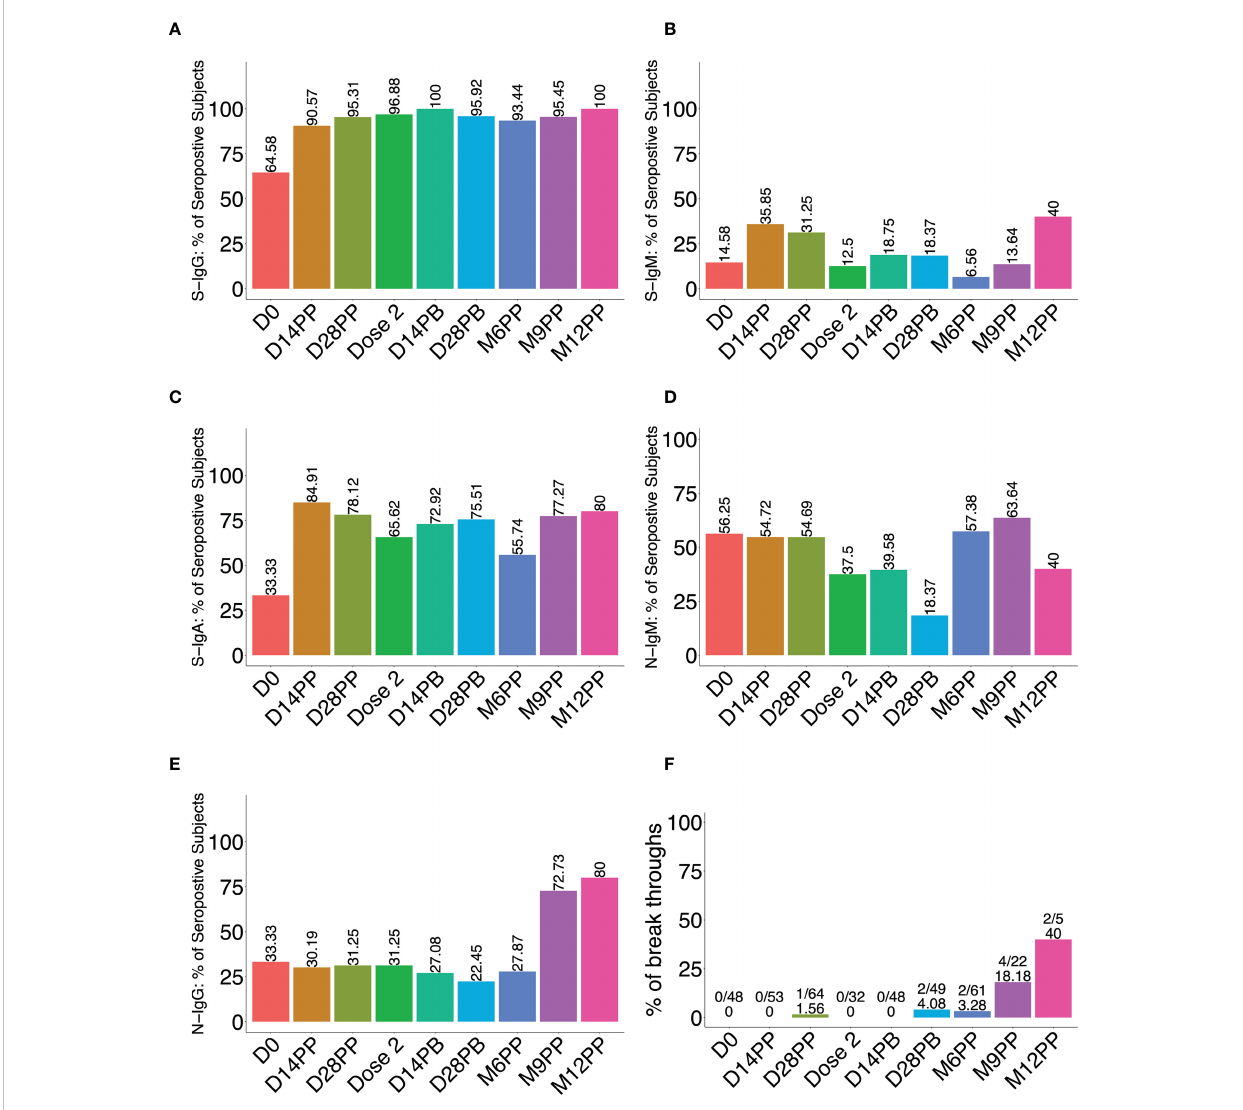
FIGURE 3 Percentage of seropositive participants following vaccination. Figure 3 illustrates the proportion (%) of participants with spike-directed IgG (A) , IgM (B) , IgA (C) , and anti-nucleoprotein IgM (D) ad IgG (E) antibodies at various follow-up time points after vaccination (x-axis). (F) is a bar graph depicting the proportion of breakthrough subjects, de fi ned as those who experienced an 11-fold increase in the concentration of nucleoprotein- directed IgG antibodies at each time